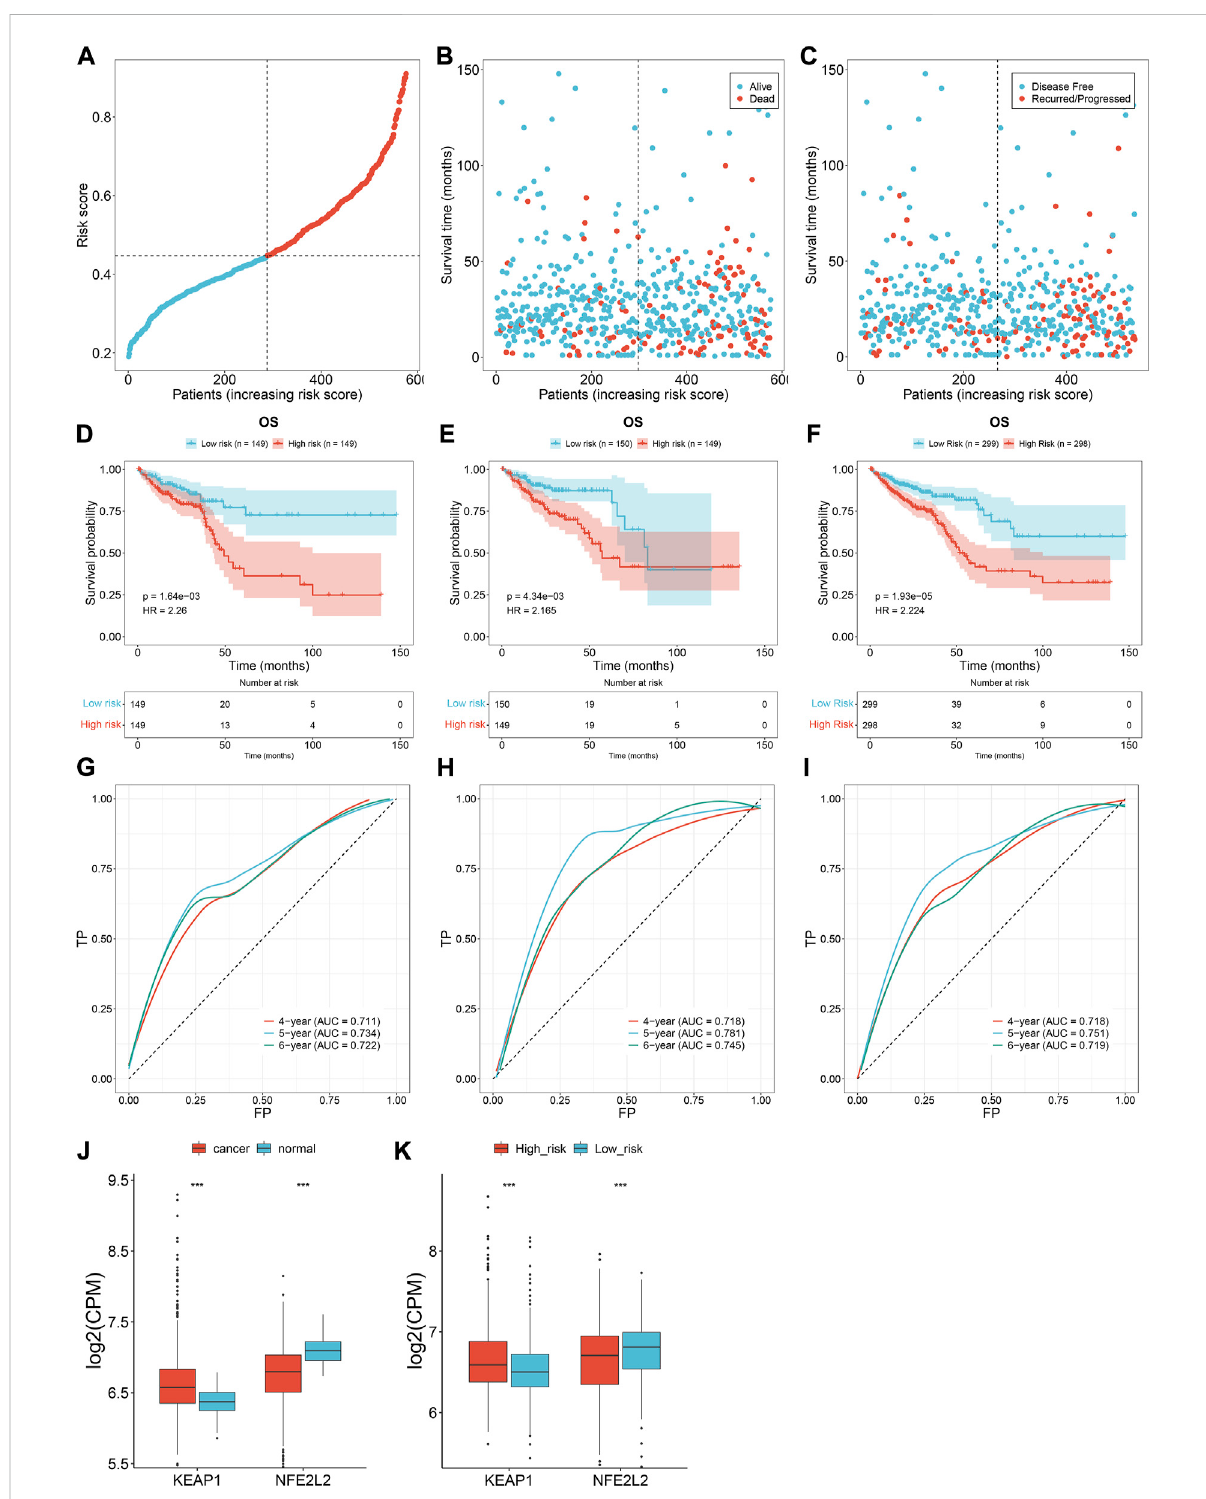
FIGURE 2 Oxidative stress-related gene signature accurately predicts CRC prognosis. (A) Distribution of the risk score derived from the oxidative stress- related gene signature in TCGA CRC patients. The vertical dotted line represents the median value. Red dots, high-risk samples; blue dots, low-risk samples. (B) Scatter plots of alive (blue) and dead (red) cases along the increasing risk score. (C) Scatter plots of disease-free (blue) and recurred/ progressed (red) cases along the increasing risk score. (D – F) Kaplan – Meier OS for high- and low-risk subsets within the (D) training set, (E) the testing set, along with (F) the total set. (G – I) ROCs under 4-, 5- and 6-year survival for the (G) training set, (H) the testing set, along with (I) the total set. (J) Comparison ofthe expression of twomaster regulatorsof oxidative stress ( NRF2 and KEAP1 )innormal versus CRC tissues. (K) Comparison of the expression of NRF2 and KEAP1 in r high- and low-risk subsets. *** p < 0.001. Total set: N = 597; training set: N = 298; testing set: N =